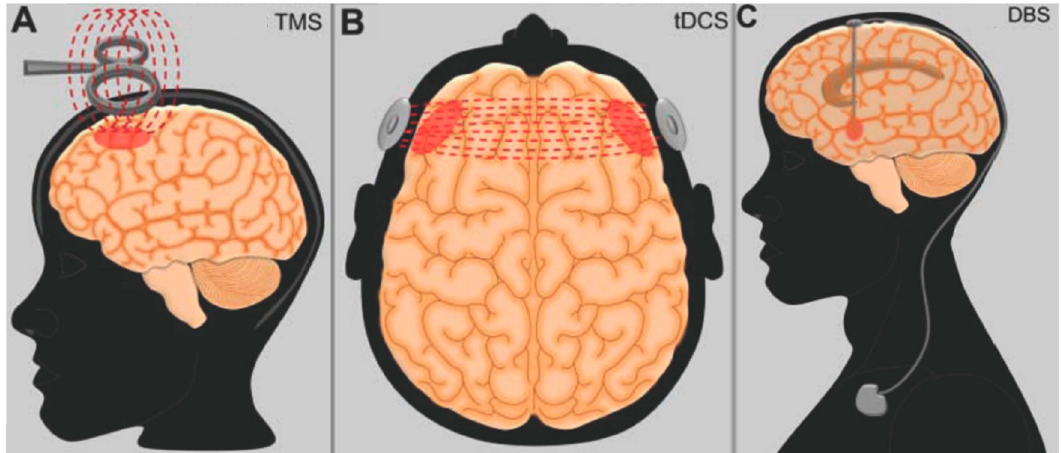
Figure 2. Schematic representation of neuromodulation treatments investigated in patients with post-traumatic stress disorder. ( A ) Transcranial magnetic stimulation (TMS); ( B ) transcranial direct current stimulation (tDCS); ( C ) deep brain stimulation (DBS).